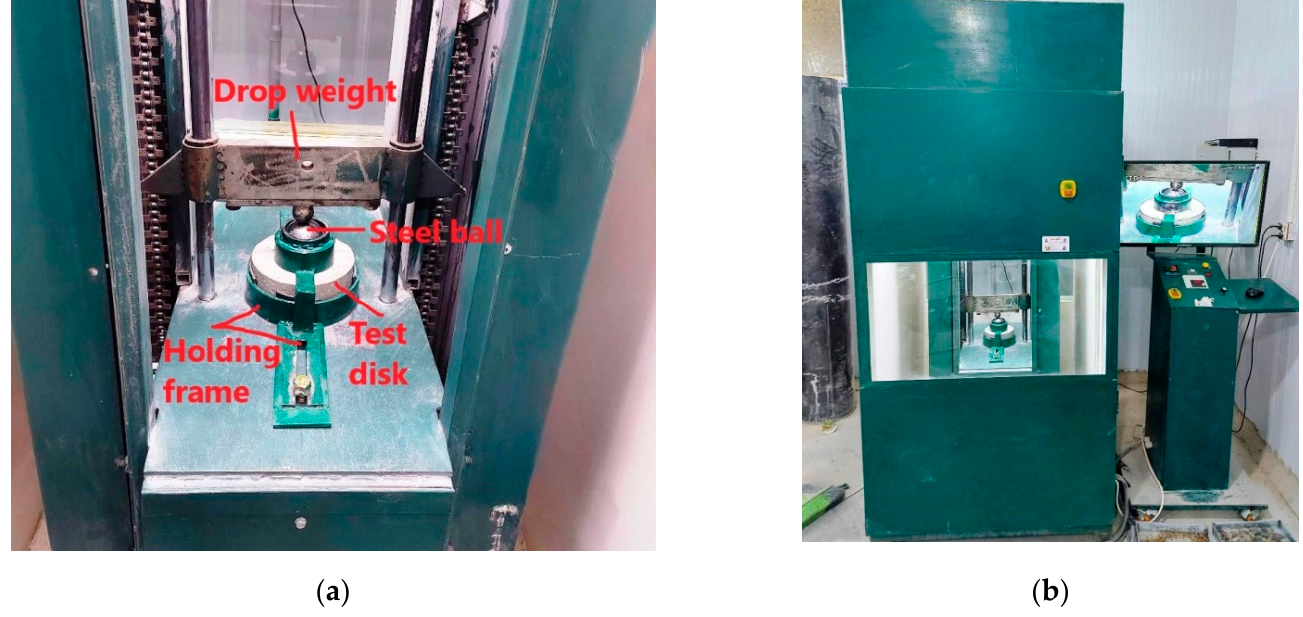
Figure 1. The impact testing ( a ) disk specimen’s holding apparatus ( b ) testing machine.